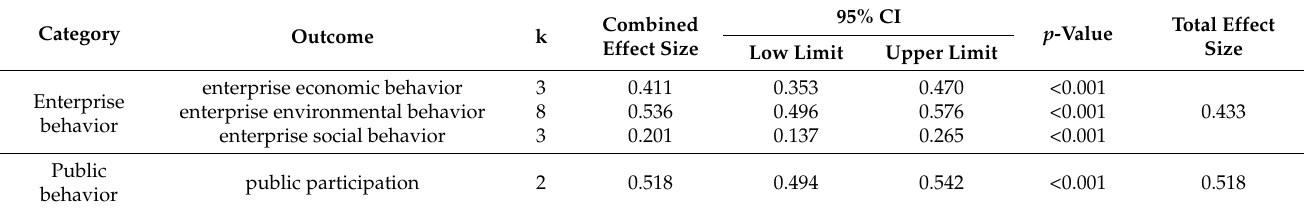
Table 5. Result of